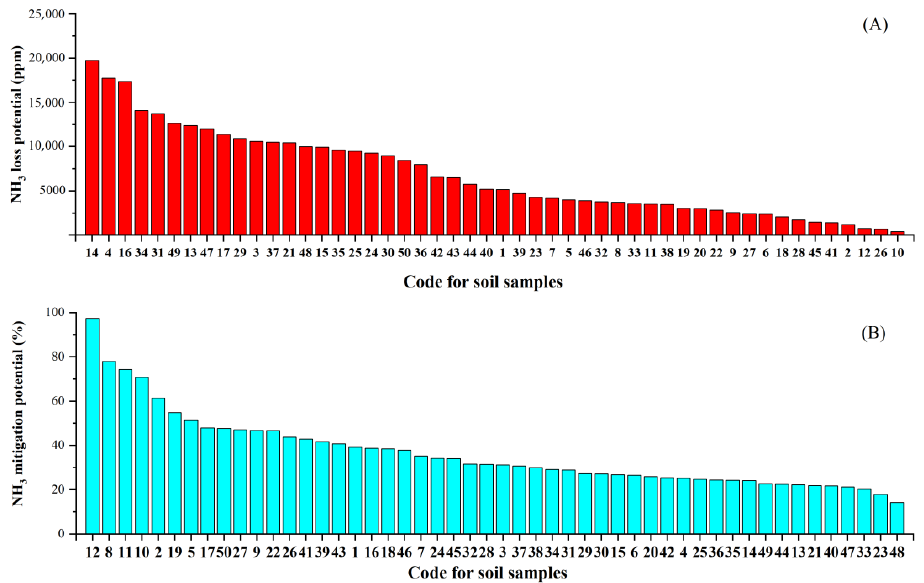
Figure 3. Factors influencing NH 3 losses from rice systems across China. ( A ) NH 3 loss from of 50 paddy soils from across China, ( B ) NH 3 reduction efficiency of using urea fertilizer with a urease inhibitor (Limus ® , the UI treatment) compared to urea. The number along the X axis is the code number for each paddy soil, as detailed in Table S1.